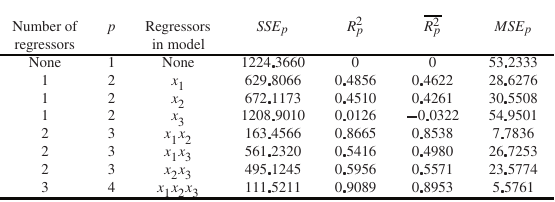
Table 7. Variableselection forthe